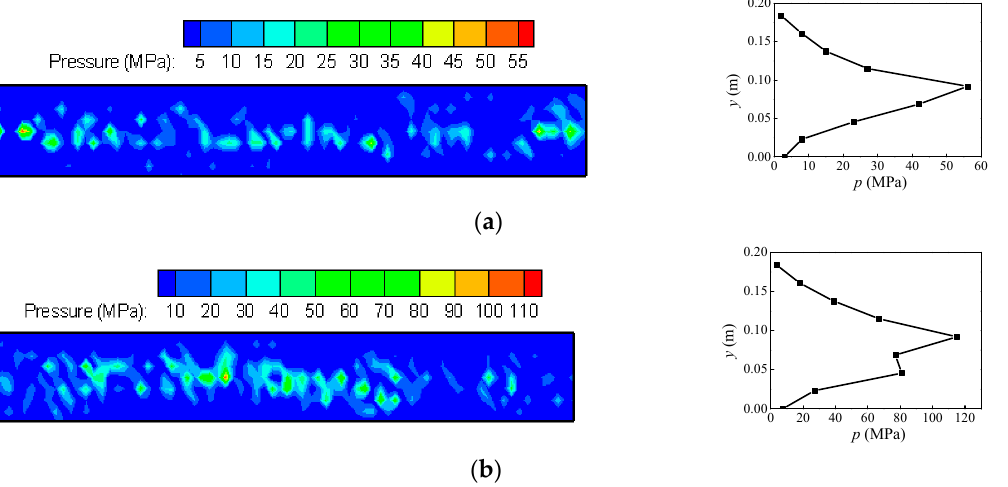
Figure 11. Distribution of high-pressure zones: ( a ) t = 59 s; ( b ) t = 200 s.